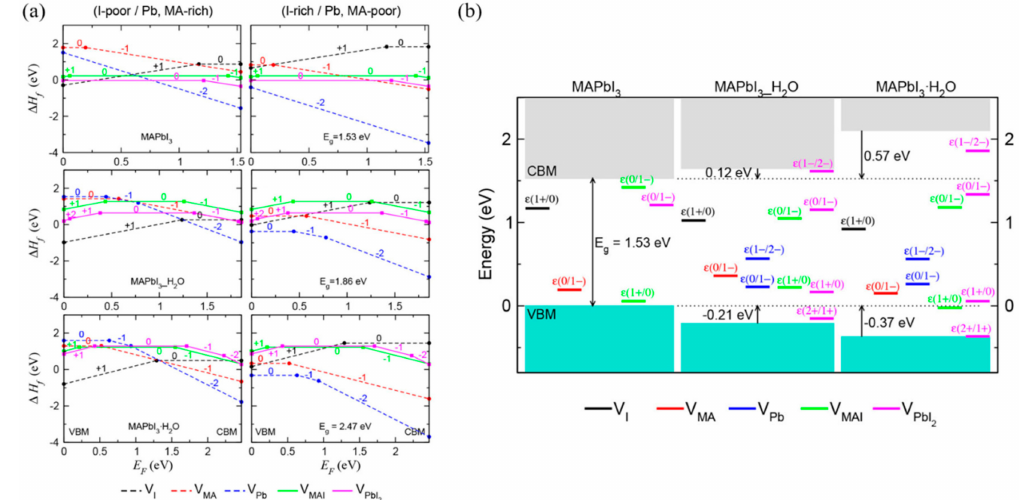
Figure 9. DFT calculation of perovskite’s degradation pathway in water. ( a ) Formation enthalpies of vacancy point and pair defects as a function of the Fermi energy (E F ) under I-poor (Pb-, MA-rich) conditions (left) and I-rich (Pb-, MA-poor) conditions (right). ( b ) Band alignment and thermodynamic transition levels in MAPbI 3 , water-intercalated MAPbI 3 _H 2 O, and monohydrate MAPbI 3 · H 2 O, where deep-lying Pb 5d levels are used as a reference for the VBM and CBM of each phase